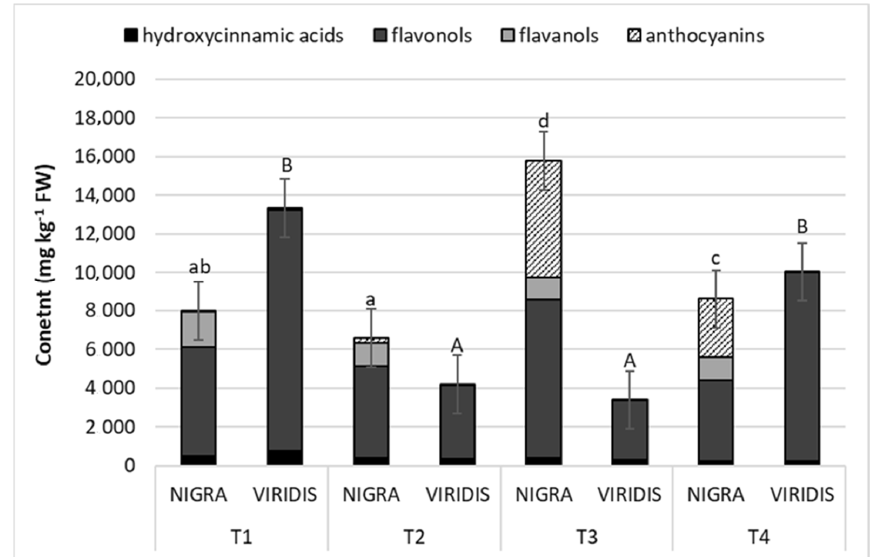
Figure 4. Content of the main polyphenolic classes (g kg − 1 FW) of Sambucus nigra (NIGRA) and S. nigra var. viridis (VIRIDIS) fruits during different developmental stages (T1–T4). Different small letters (a–d) denote statistically significant differences between developmental stages for the NIGRA genotype, and different capital letters (A–B) denote statistically significant differences between developmental stages for the VIRIDIS genotype at p < 0.05 (Duncan